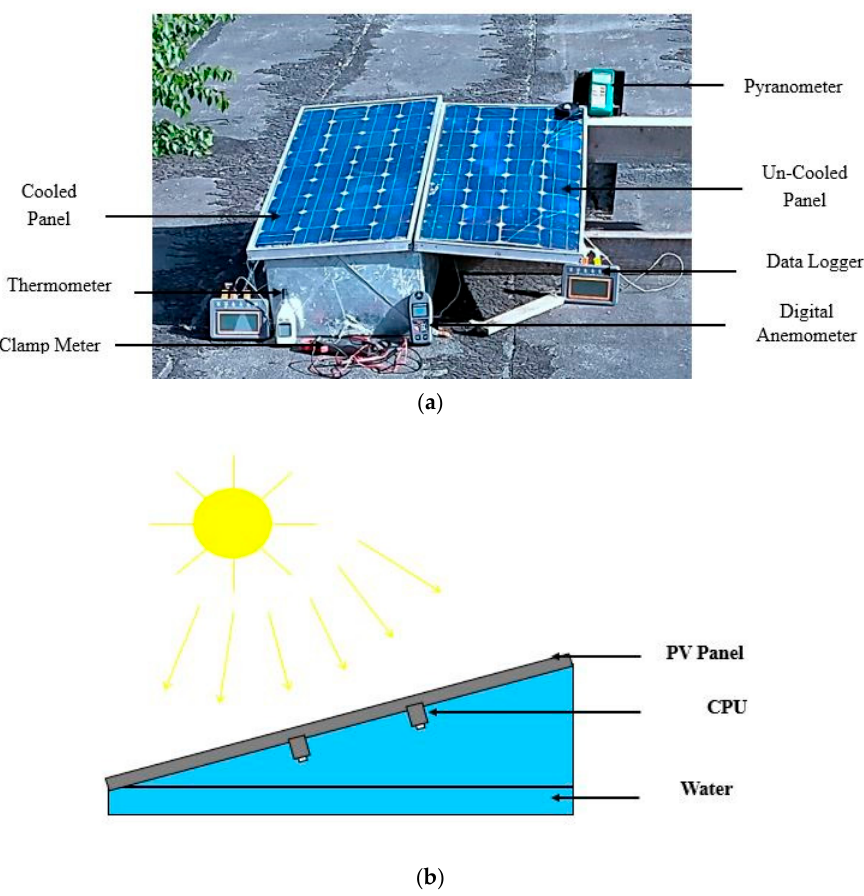
Figure 4. ( a ) Experimental setup ( b ) Schematic diagram of experimental test rig.